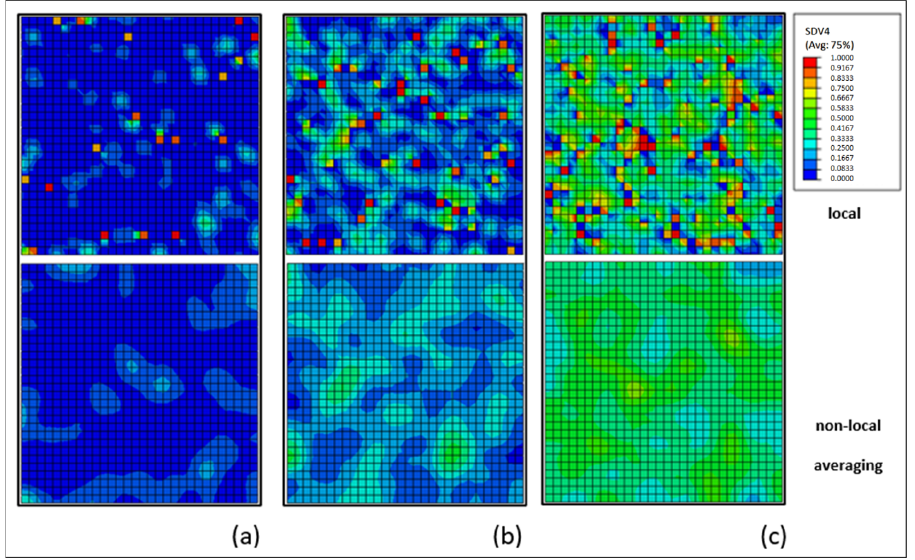
Figure 12. Influence of different values for γ on the distribution of local pitting parameters, λ e , (upper part) and the effect of application of the non-local averaging method (lower part); ( a ) γ = 0.1, ( b ) γ = 0.4 and ( c ) γ = 0.9.